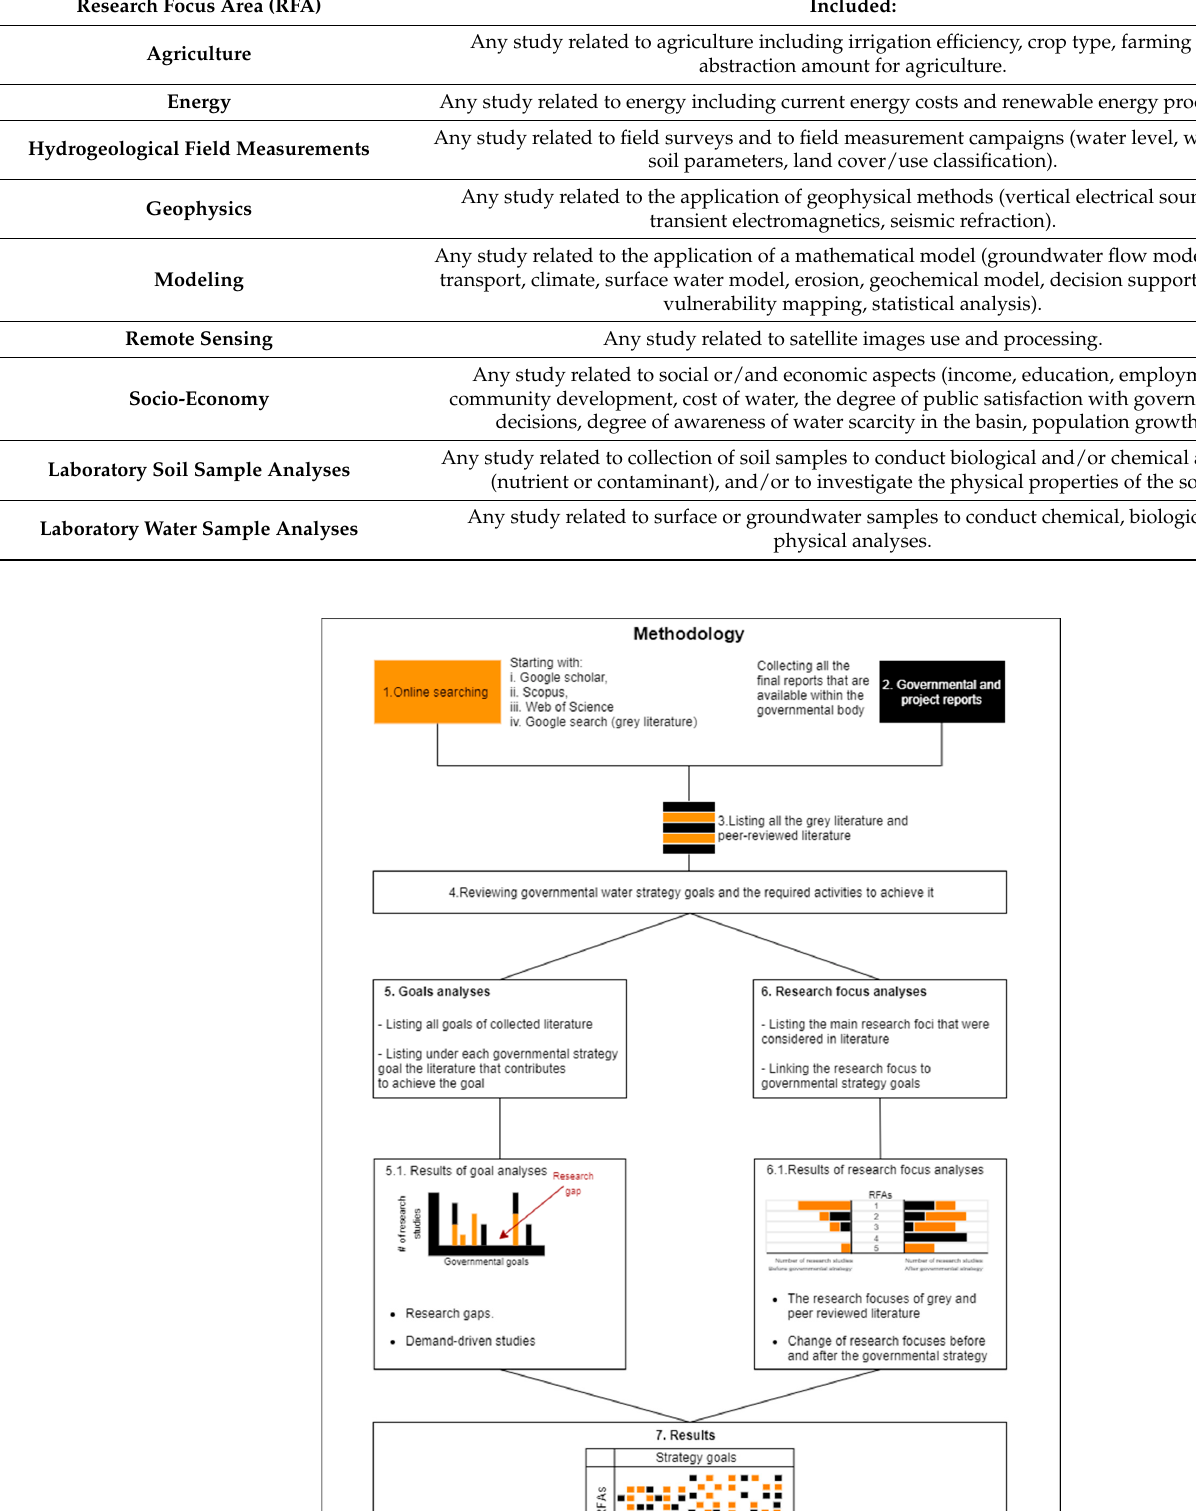
Table 3. Description of the categorization of the research focus areas (RFAs) in the collected studies. Research Focus Area (RFA) Included: